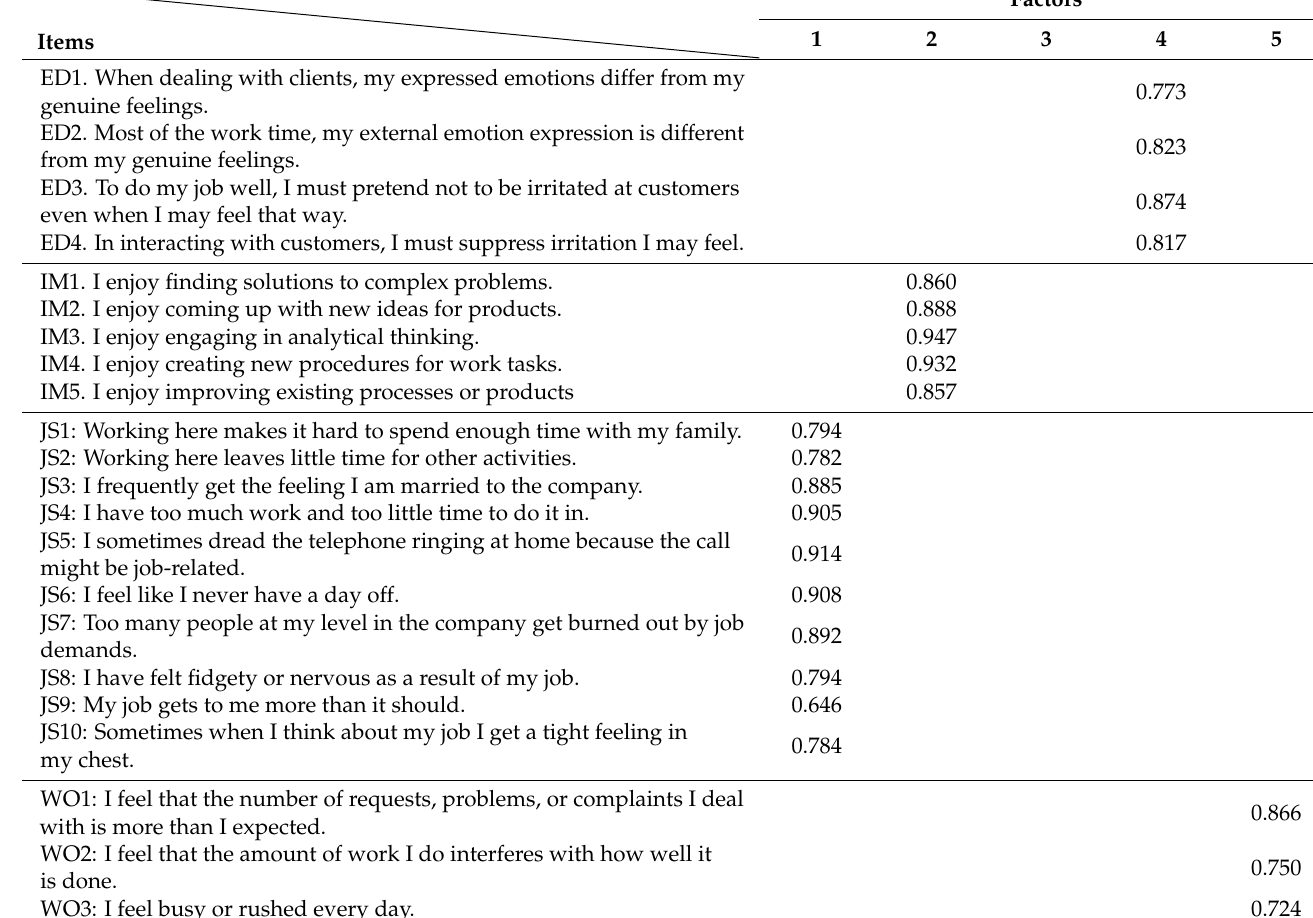
Table 1. Results of the principal component analysis with oblique